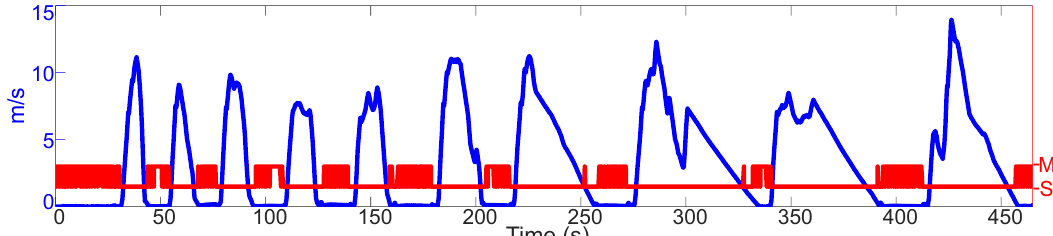
Figure 8. Shown is the RF output (red, S = standstill, M = motion) and the velocity over ground of the vehicle (blue). Vehicle: Suzuki GSX-R750 K2. Motorization: 4 cylinder, 749 cc. Power source: